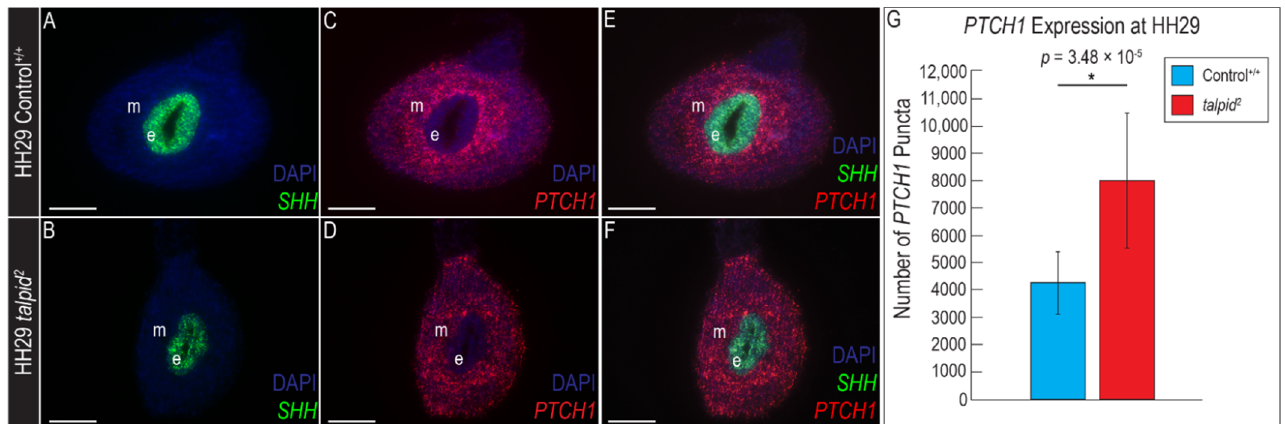
Figure 7. Hypoplastic GI phenotype does not correlate with increased PTCH1 expression. ( A – F ) RNAscope in situ hybridization for ( A , B ) SHH , ( C , D ) PTCH1 or ( E , F ) both SHH and PTCH1 in the hindgut epithelium of transverse sections of HH29 control +/+ and ta 2 hindguts. ( G ) Puncta quantification for PTCH1 in HH29 control +/+ and ta 2 hindguts. e: epithelium, m: mesenchyme. Scale bars: 100 μ m ( A – F ). Error bars represent the mean data ± s.d. Statistical analysis was performed utilizing Student’s t -test (* denotes p < 0.05).